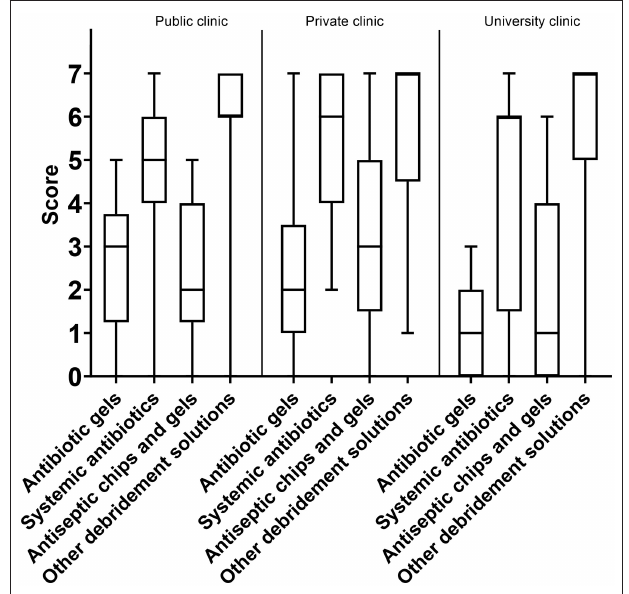
FIGURE 10 | Box-plot with score of cost cleaning treatments segmented by responder’s workplace.